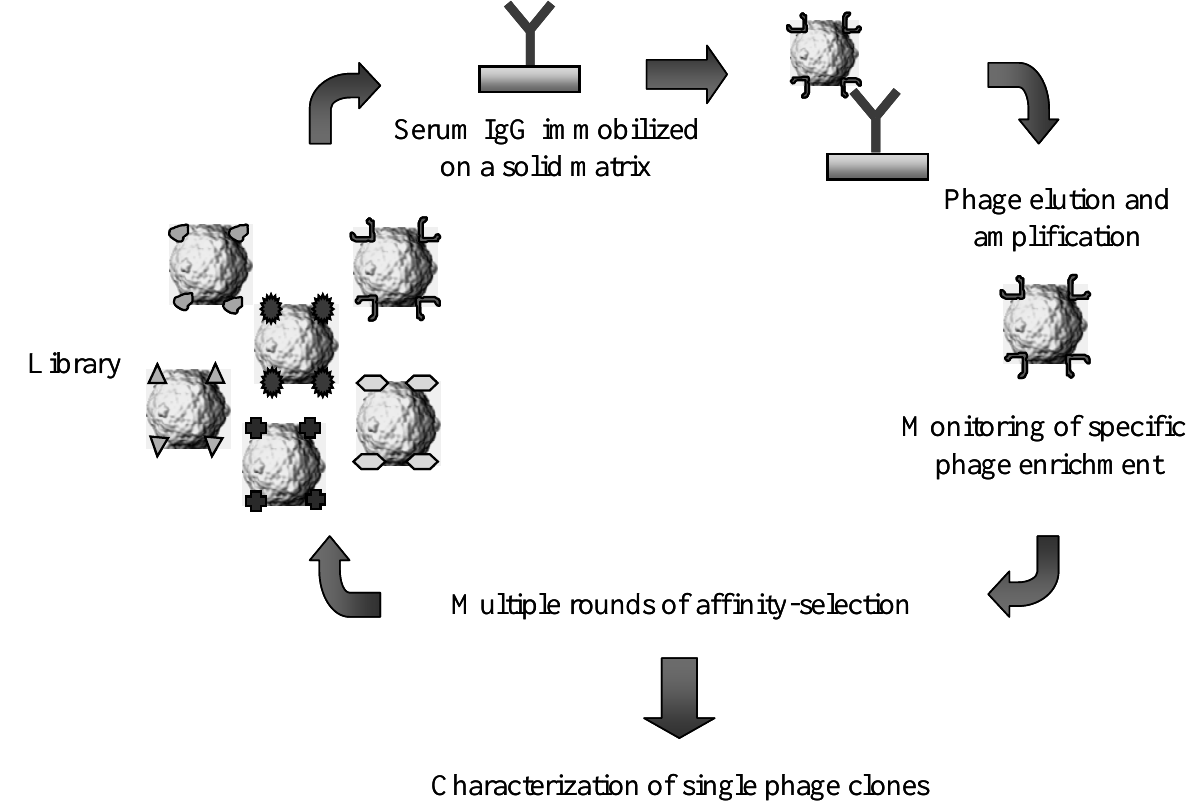
Figure 2. Schematic representation of the affinity-selection procedures employed for challenging lambda-display libraries of antigen fragments with serum